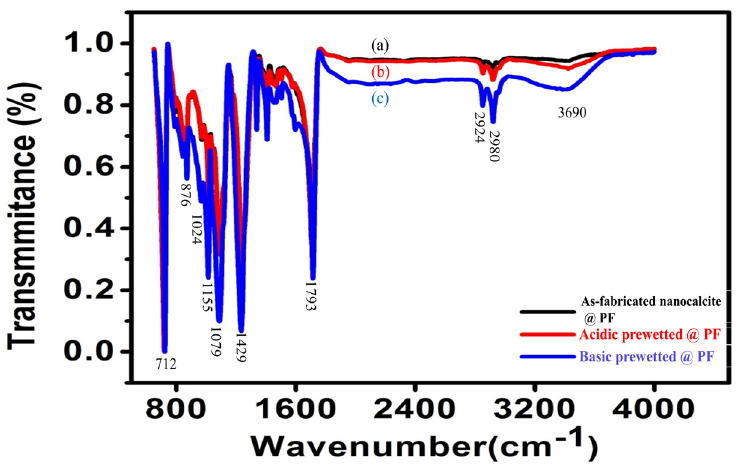
Figure 3. Normalized FTIR spectrum of ( a ) as-fabricated nanocalcite @ PF, ( b ) acidic prewetted nanocalcite @ PF, and ( c ) basic prewetted nanocalcite @ PF.